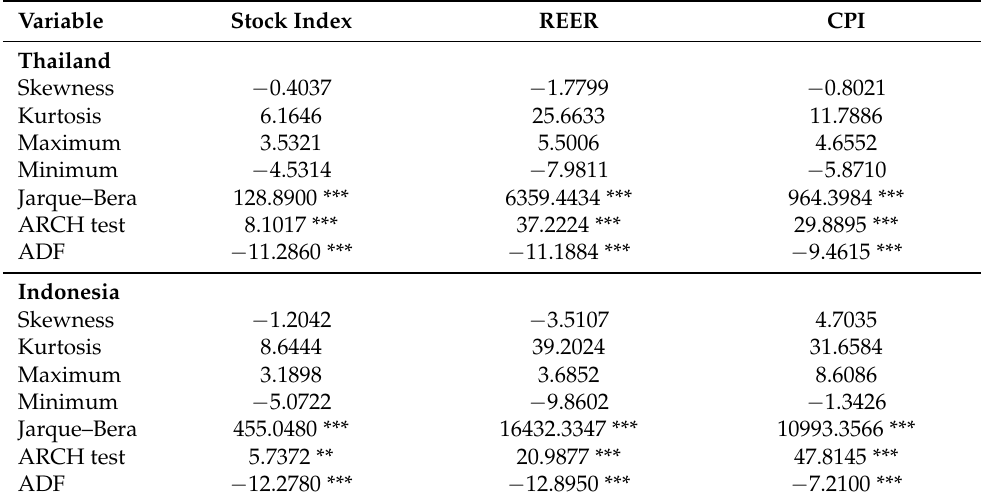
Table 3. Descriptive statistics of normalized return